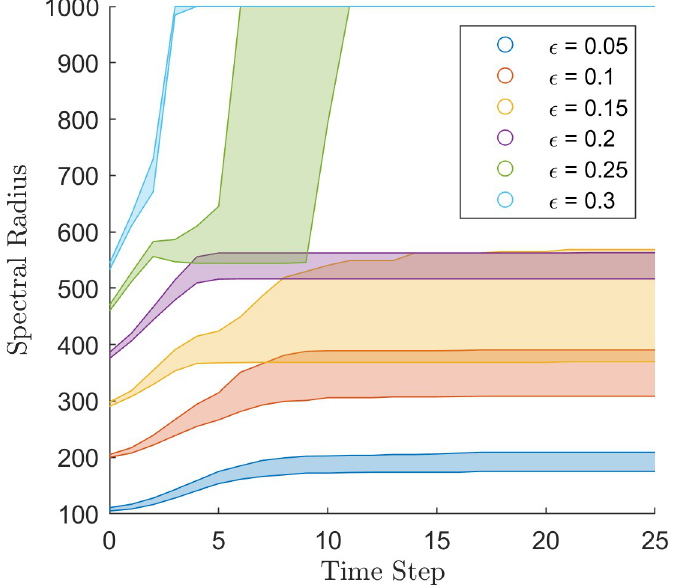
Fig 6. Spectral radius through time of the simulations that used the H-K bounded confidence model with different values of � .